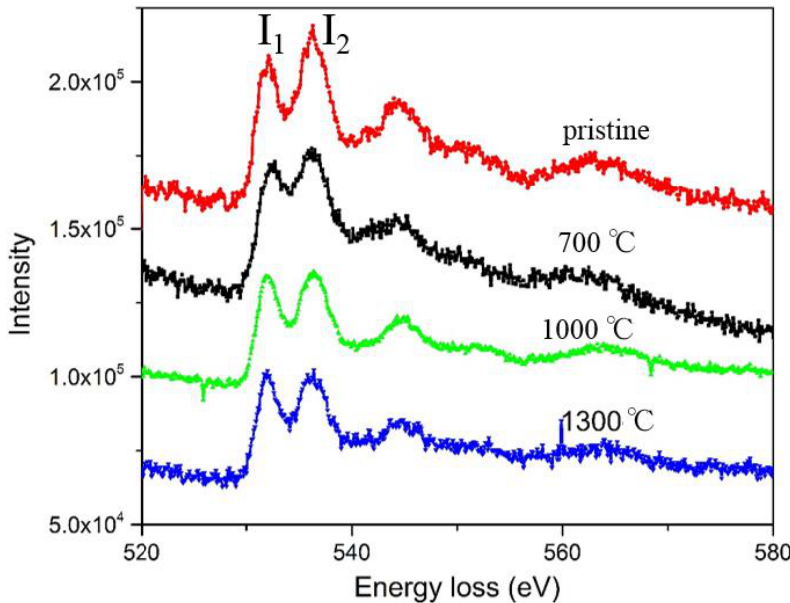
Figure 6. The O K-edges of differently quenched single-crystal electrolytes. The relative ratio of double peaks I 1 /I 2 changes obviously with the quenching temperature, highly correlated with the metastable La A2 formation.